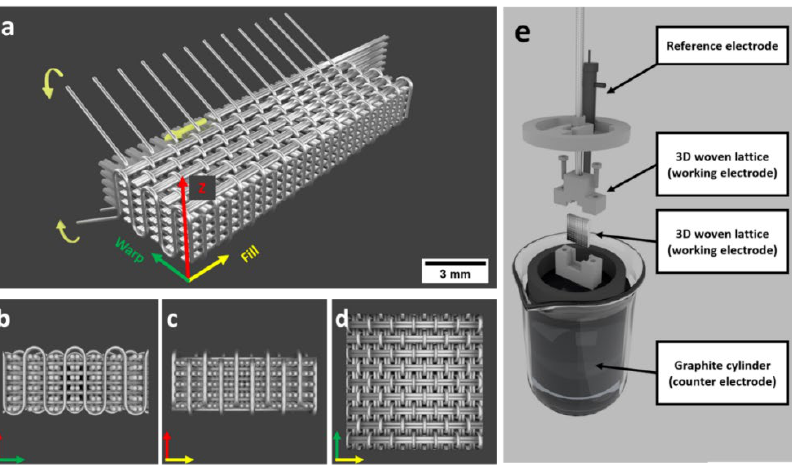
Figure 1. ( a ) A schematic of the 3D-woven lattice with warp, fill, and Z wires woven in three orthogonal directions; ( b ) 2D view in fill direction; ( c ) 2D view in warp direction; ( d ) 2D view in